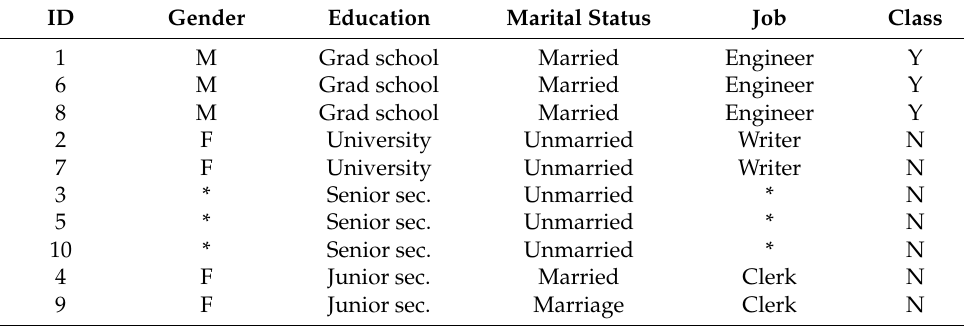
Table 4. Anonymized fragment 2 (satisfying